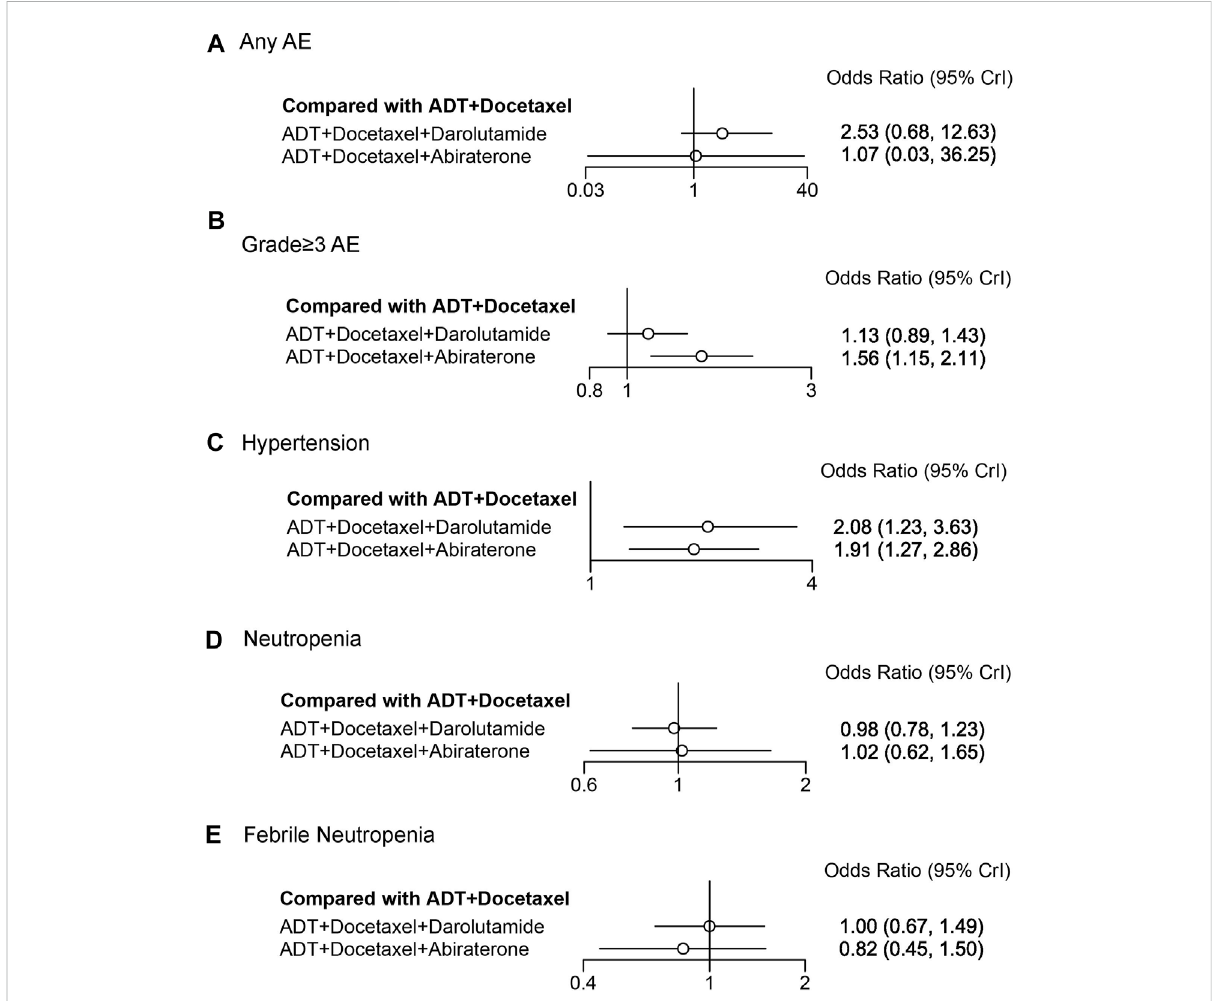
Forest plot representing a comparison of adverse events for systemic triplet therapy compared with ADT plus docetaxel. HR and 95% CrI are represented. (A) Any AE; (B) grade ≥ 3AE; (C) hypertension; (D) neutropenia; (E) febrile